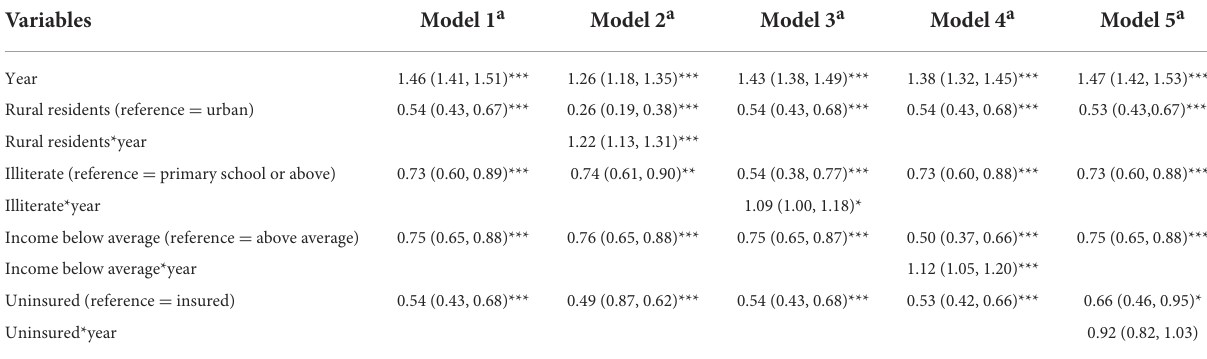
TABLE 4 Random effect model for psychotherapy of adults with schizophrenia: odds ratio and 95%